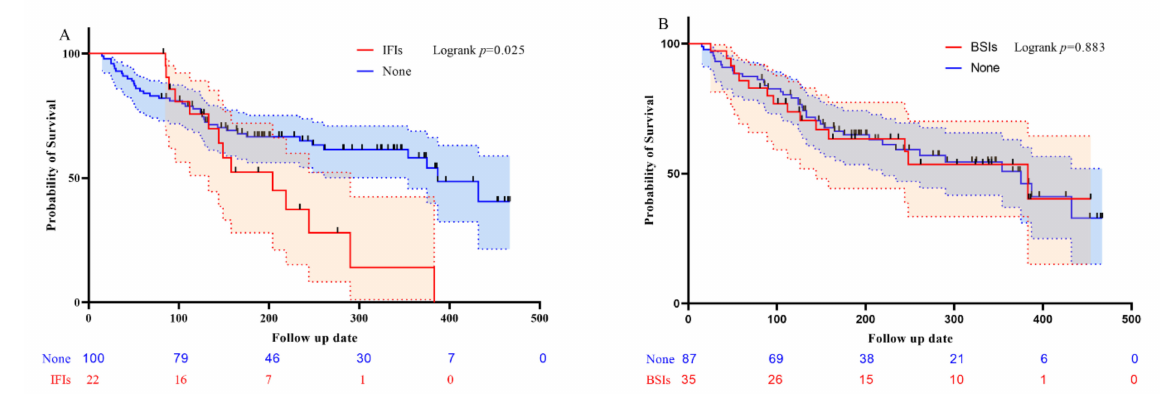
Figure 1. Overall survival for patients with AML treated with VEN-based combination chemotherapy. The red and blue shade bands represent approximated 95% confidence interval. ( A ) Overall survival according to IFIs. ( B ) Overall survival according to BSIs. BSIs: bloodstream infection; IFIs: invasive fungal